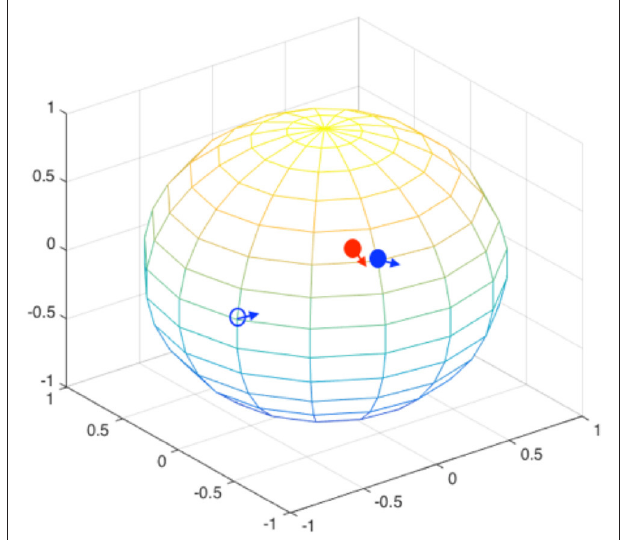
FIGURE 4 | Orientation mismatching scenarios. Two rotation angles can be mapped to the points on a sphere, the third angle is the in-plane rotation indicated using the arrow at each point. The red solid circle and the associate arrow indicate the orientation of one experimental pattern, the blue circles and arrows indicate possible orientations. The orientation deviation of solid blue circle from the correct values (red solid circle) is due to the discretization of SO(3) rotation space; and the orientation mismatching to the open blue circle is attributed to large conformational difference. For the models that are similar to the correct complex structure, the orientations are likely to be identified to the vicinity of correct orientations (see Figure 5 ).